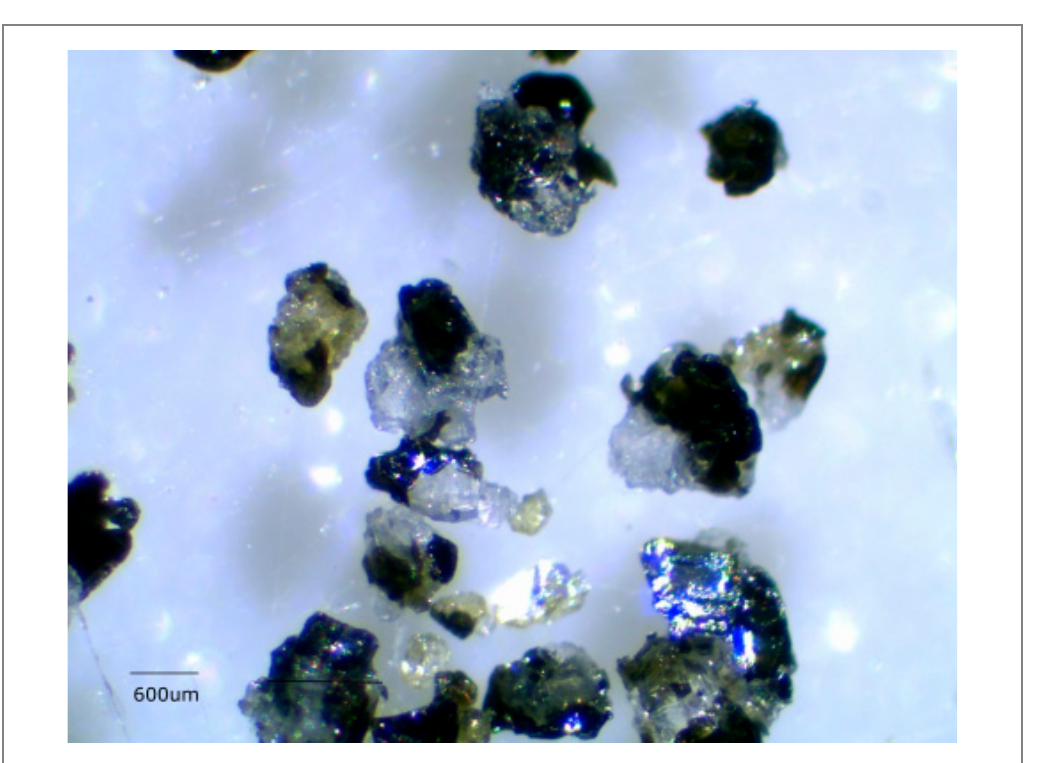
Figure 7 - SIS-454-72 cm depth. Light minerals are quartz and biotite.